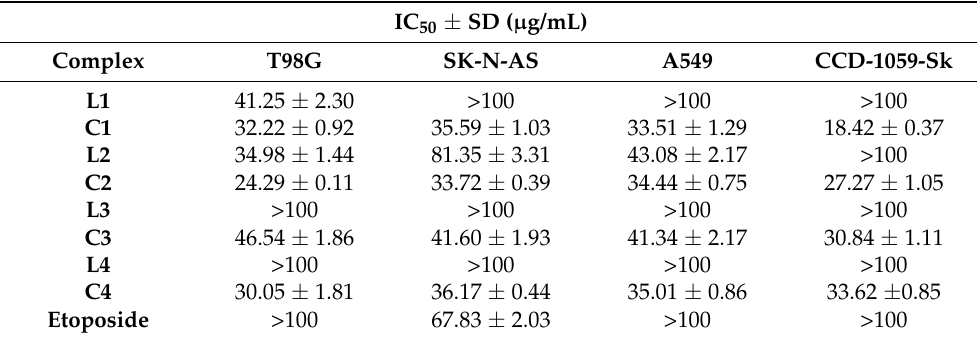
Table 2. Cytotoxic effect of the investigated compounds against glioblastoma (T98G), neuroblastoma (SK-N-AS), lung adenocarcinoma (A549) cell lines and human normal fibroblasts (CCD-1059Sk) determined by MTT assay after 24 h incubation.